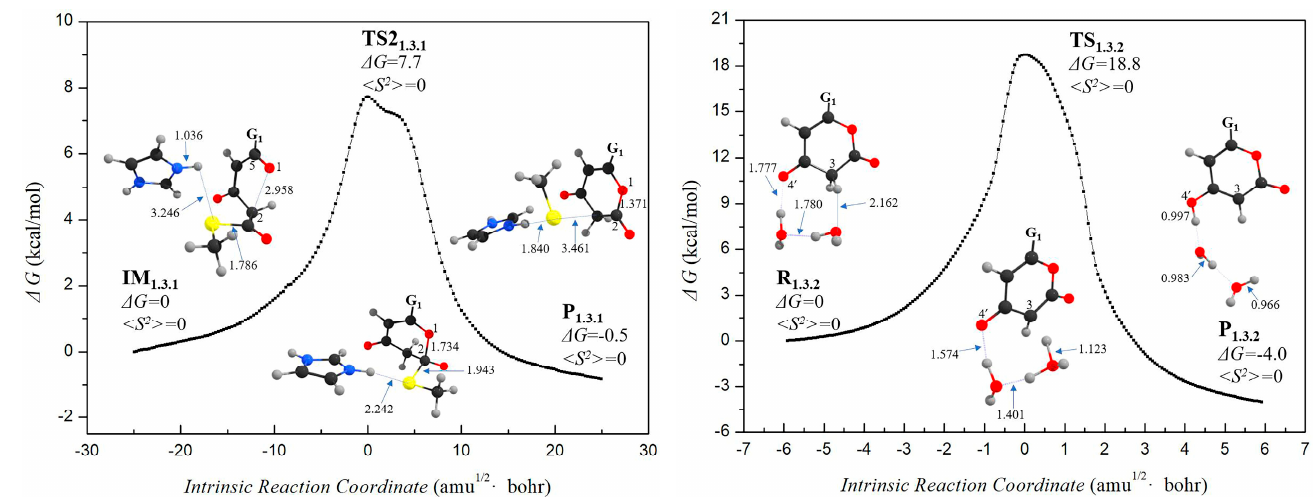
Figure 3. Under the calculated level of CAM-B3LYP/6 − 31+G**, the reaction potential energy curve and the key geometric parameters of each stable point of the endo esterification process of ( a ) caffeoyl deacetyl thioester(1.3.1) and ( b ) the isomerization process of caffeoyl deacetyl thioester(1.3.2). The reaction mechanism can be seen in Schemes 3–6. Group G 1 is shown in Scheme 1.